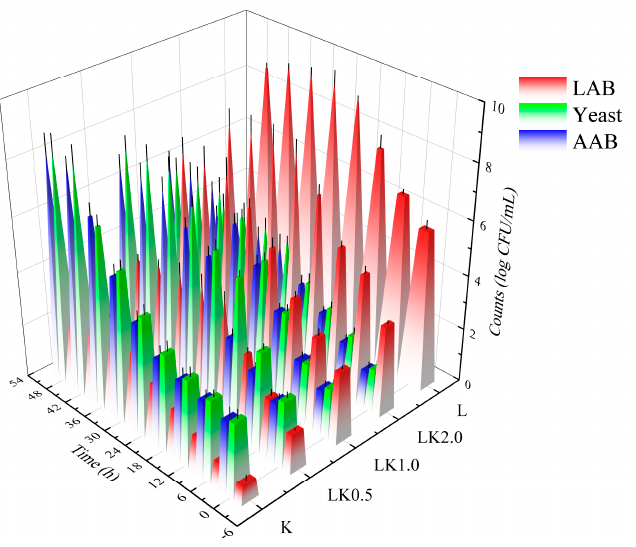
Figure 1. Changes in the microbial content of fermented soy milk samples. K = kombucha fermen- tation; LK0.5, LK1.0, and LK2.0 = Lactobacillus bacteria (LAB) fermentation combined with kombucha at mass ratios of 0.5, 1.0, and 2.0, respectively; L = LAB fermentation.